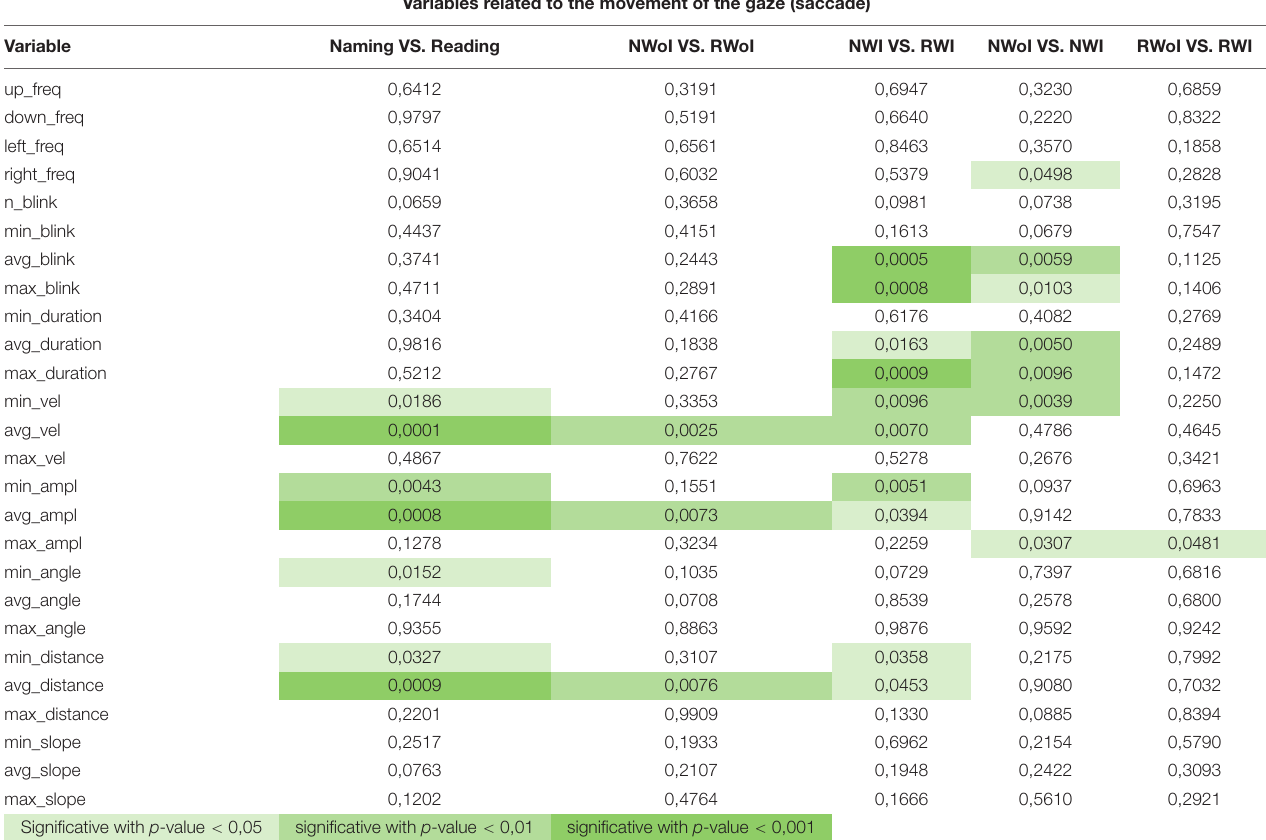
TABLE 2 | P -values generated by the one-way ANOVA on saccade related variables when comparing three pairs of tasks: NWoI vs. RWoI, NWI vs. NWoI, and RWI vs. RWoI. Variables related to the movement of the gaze